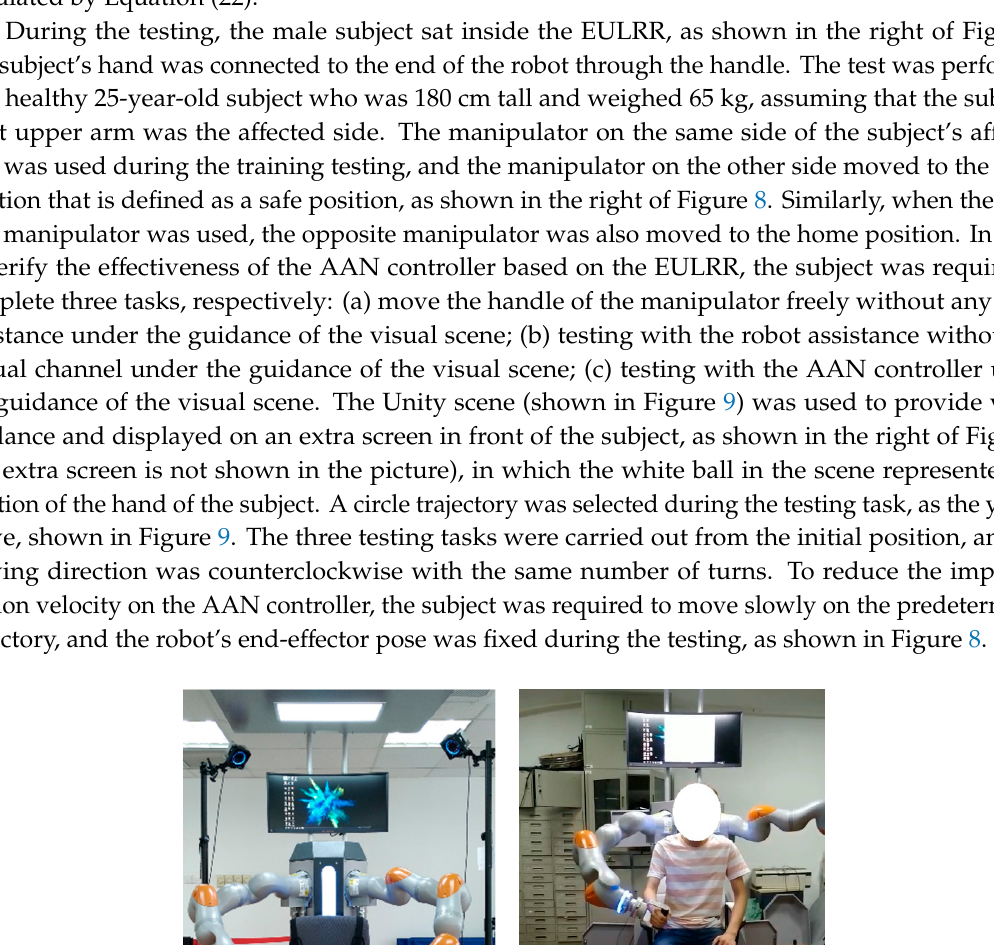
Figure 9. The Unity scene for the testing task. 4.2. Data Analysis To reduce the influence of noise on the obtained data, a Gaussian lowpass filter was used to deal with the joint position data and the joint torque data during the three testings. To further evaluate the deviation degree of the movement of the subject’s hand, the distance deviation between the actual trajectory and the expected trajectory was calculated: 2